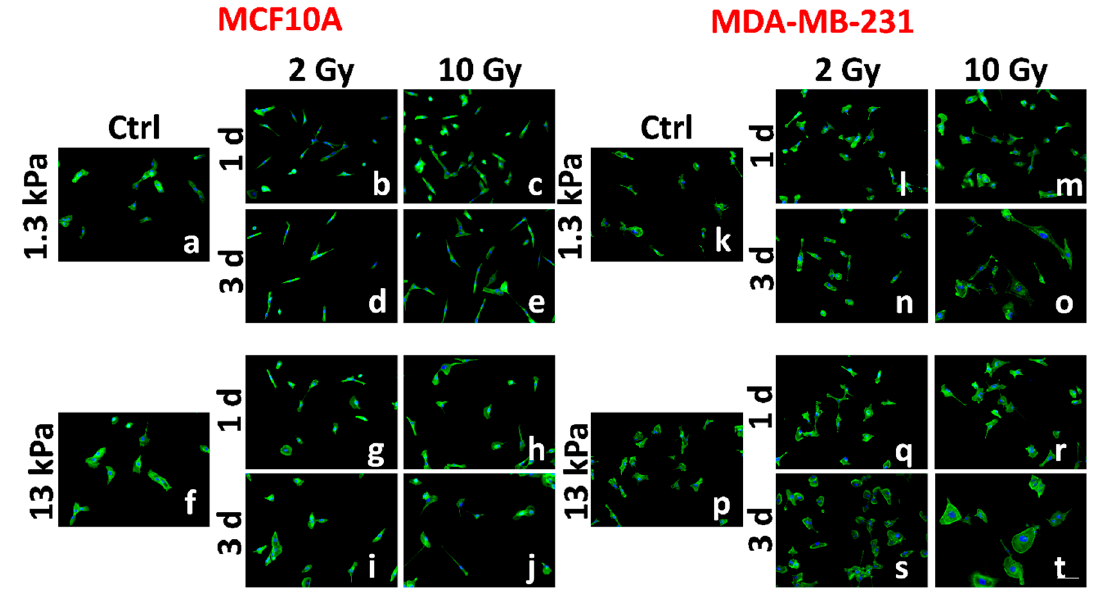
Figure 1. Representative images of two different mammary cell lines, MCF10A and MDA-MB-231, are shown. The spreading of MCF10A and MDA-MB-231 are compared before (a,f,k,p) and after RT (radiation therapy) (b–e,g–j,l–o,q–t). The cells were stained for F-actin (green) and nuclear DNA (blue). Scale bar, 100 μ m.